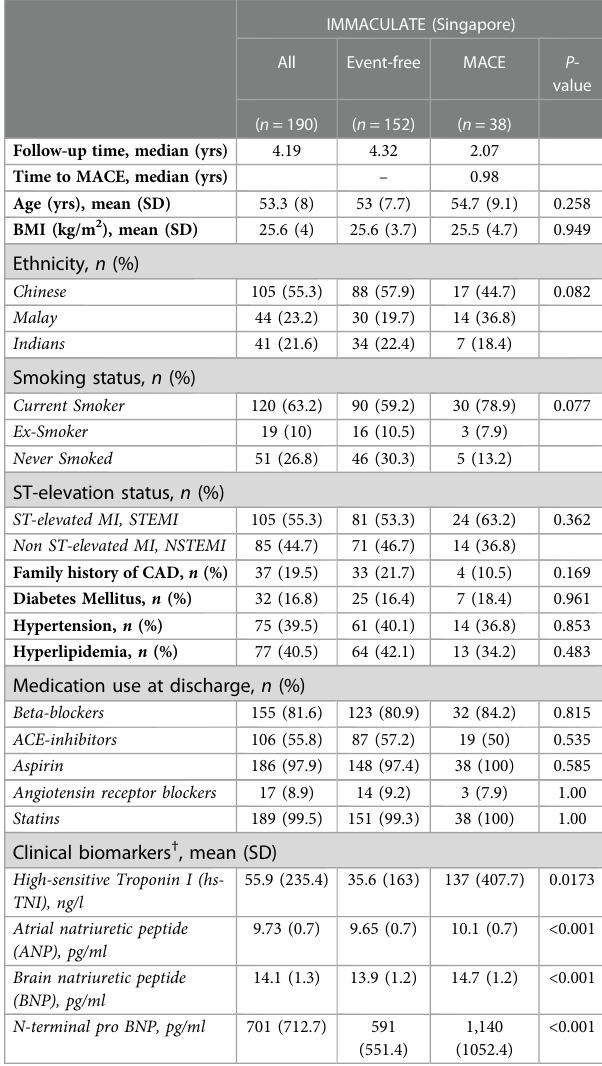
TABLE 3 Clinical characteristics of post-AMI patients in IMMACULATE study.